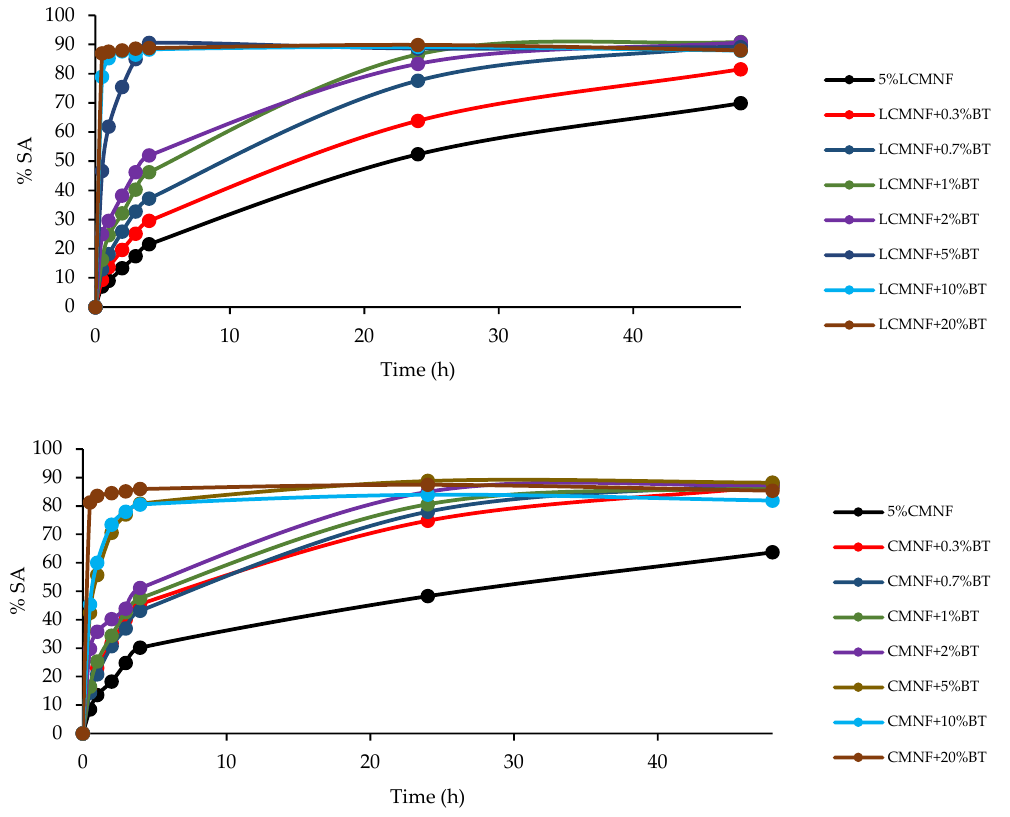
Figure 6. BT release profiles as function of DPPH scavenging activity (%SA) of bioactive LCMNF-CH and CMNF-CH aerogels.